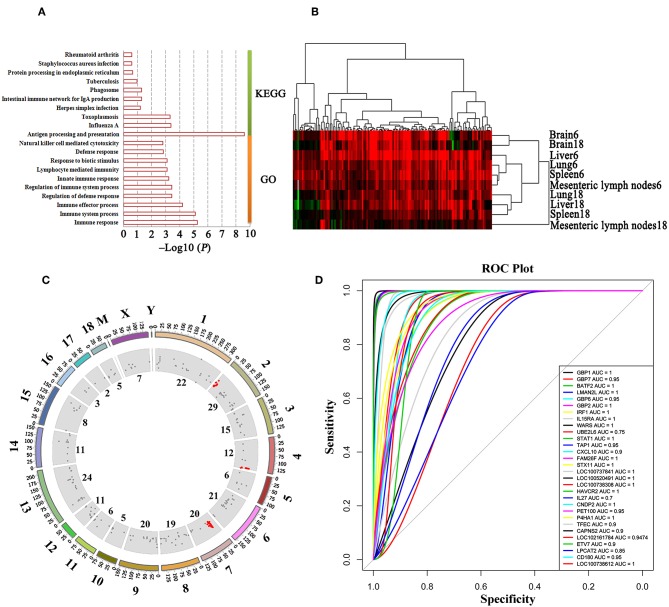
Functional annotation and transcript expressional cluster of MElightyellow module. (A) GO and KEGG enrichment of transcripts in MElightyellow module. The top 10 GO terms are listed according to the enrichment P-value. (B) Expressional clustering of transcripts in MElightyellow module. Upregulated, downregulated, and missing transcripts are denoted by red, green, and gray colors, respectively. (C) Distribution of the host genes significantly correlated with T. gondii load (HGSCTG) on the pig genome. Outer circle represents the chromosome, scatter in inner circle represents the distribution of HGSCTG, the numbers adjacent to inner circle represent the number of HGSCTG that are encoded by the chromosome, red scatter shows HGSCTG distributed on the hotspot sites. (D) ROC tests between the top 30 hub gene expressions and T. gondii parasite DNA load.